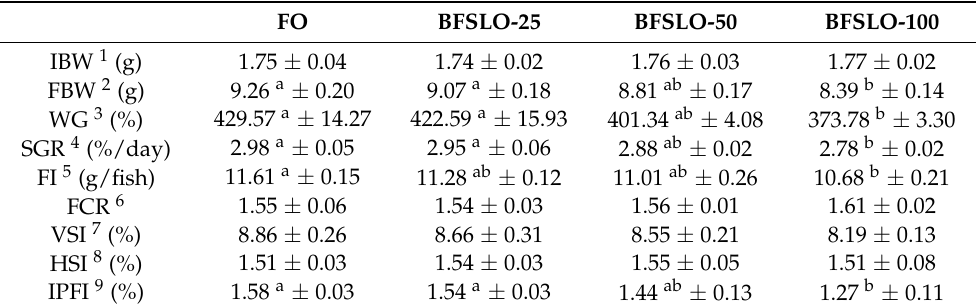
Table 4. Growth, biological indicators and feed utilization efficiency of O. macrolepis fed the four experimental diets with different gradient levels of BSFLO (25%, 50% and 100%) replacing FO (control) for eight weeks.